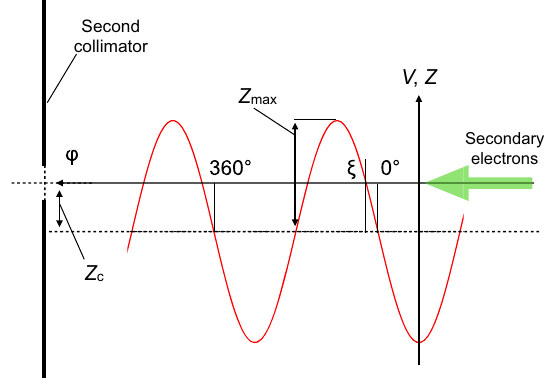
FIG. 19. Schematic illustration of the rf modulation, where V and ϕ are the voltage and phase of the rf deflector, and ξ , Z c , Z are small phase difference, displacement between slit center and rf deflection center on the second collimator, and maximum displacement induced by the rf deflection.